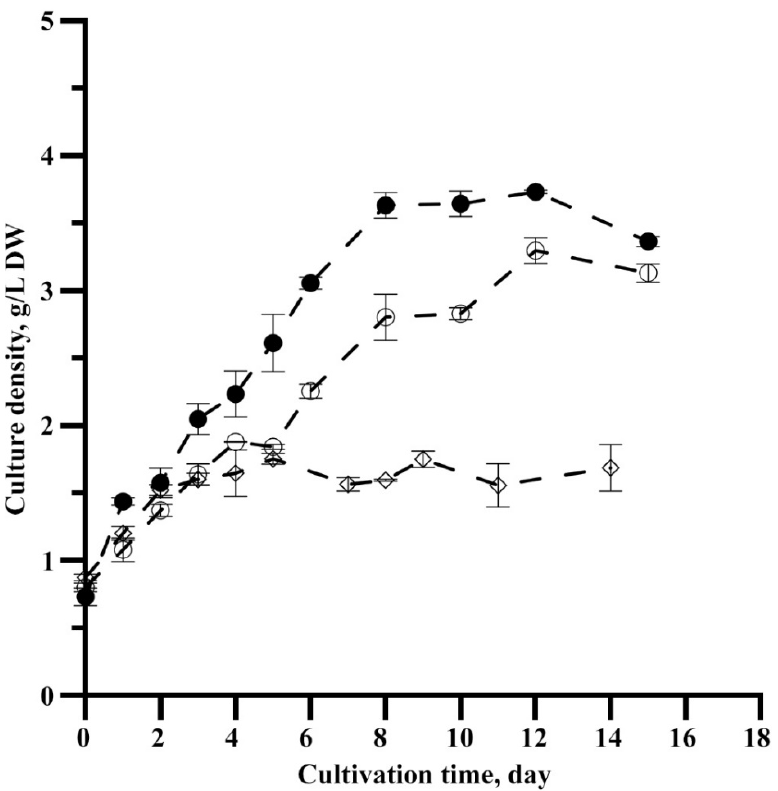
Figure 1. The density of P. purpureum culture under the different methods of carbon introduction into photobioreactor: • —additional introduction CO 2 ; capillary (the data are means of three replicates ± ∆ x